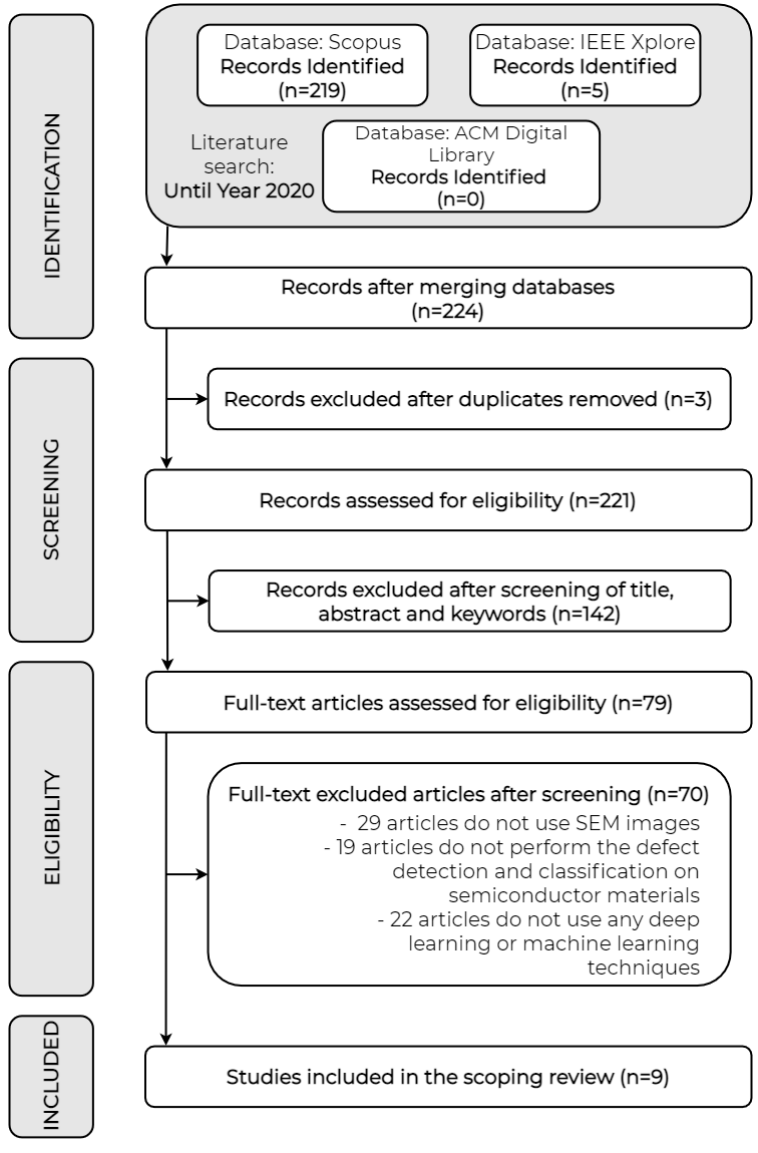
Figure 2. Search